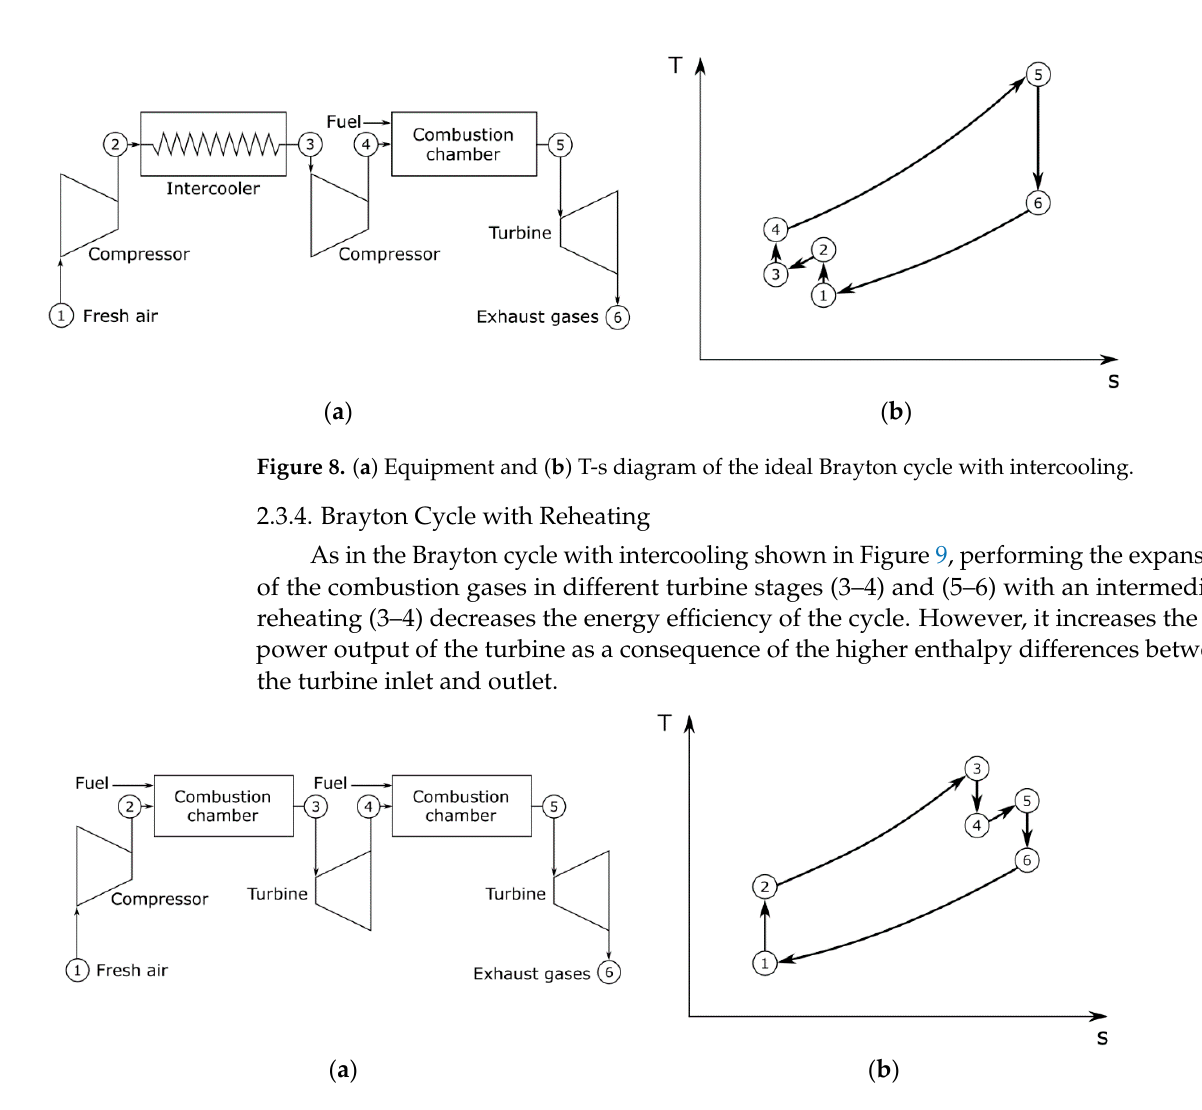
Figure 9. ( a ) Equipment and ( b ) T-s diagram of the ideal Brayton cycle with reheating.